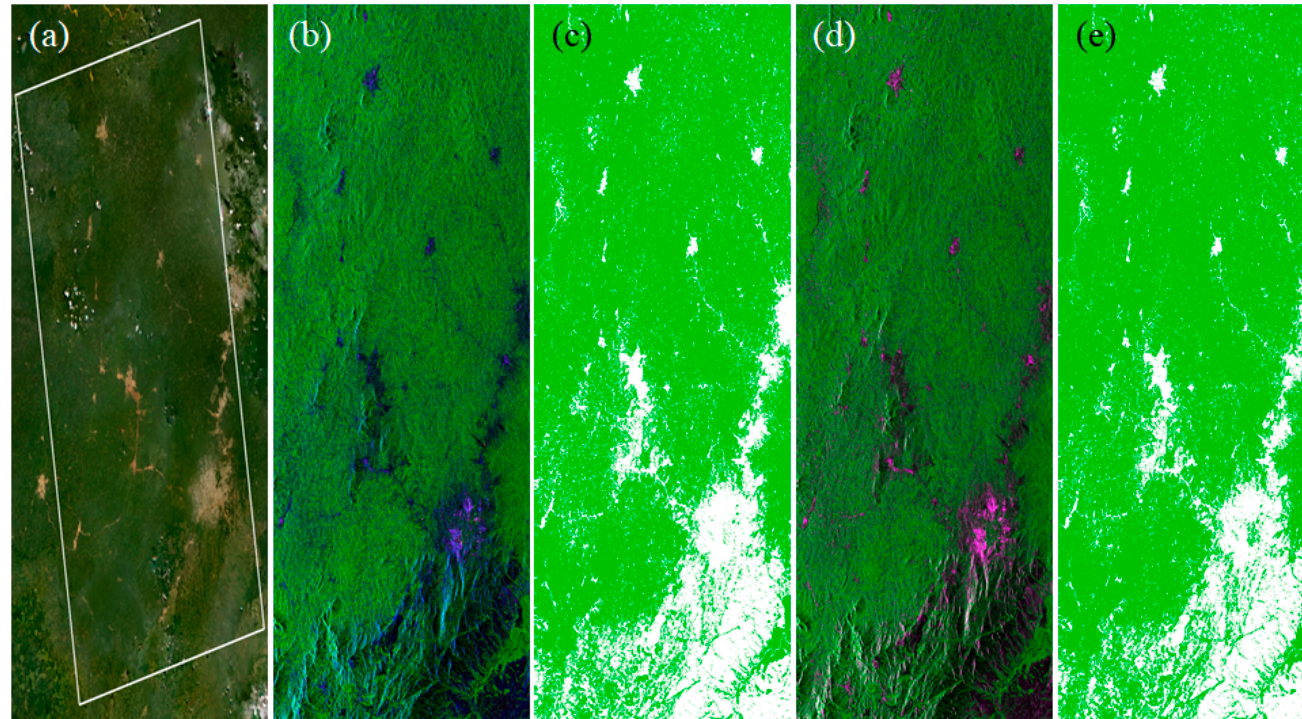
Figure 4. Forest maps of Kalimantan in Indonesia using the proposed method and 6SD method with the POLSAR data acquired on 29 October 2016 and a window size of 10 × 20 pixels. ( a ) Mosaic image acquired by Planet/Dove from June to November 2016. The white rectangle shows the observation area of PALSAR-2. ( b – e ) Same as in Figure 3. The white dotted rectangle shows the oil palm plan- tation.